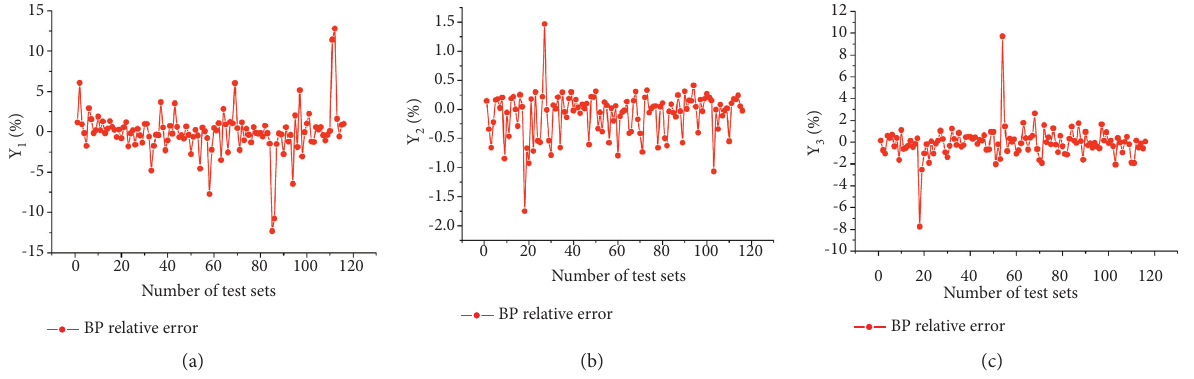
Figure 15: Fitting error percentage of BP neural network. (a) The relative error of Y 1 is relatively large, but it meets the requirements. (b) The relative error of Y 2 is relatively small. (c) The relative error of Y 3 is very small, except that one data value is